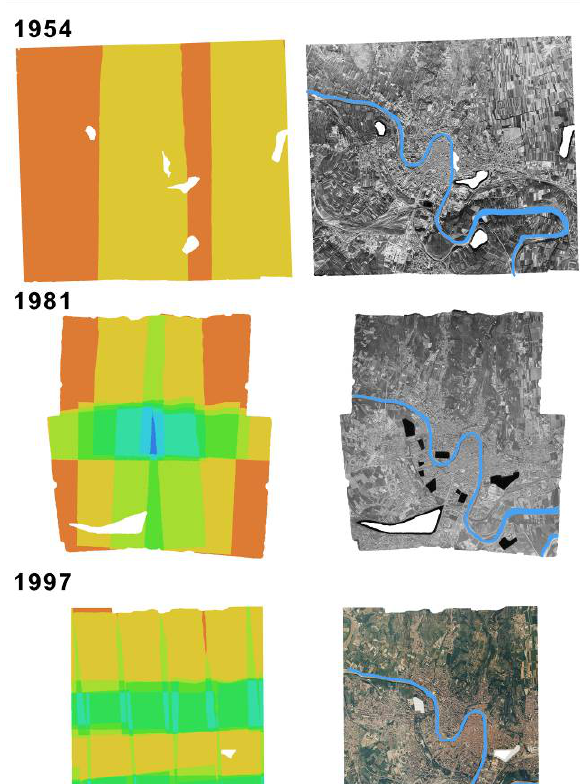
Figure 2: results of image orientation. On the left the representation of overlapping and on the right the orthophoto of the